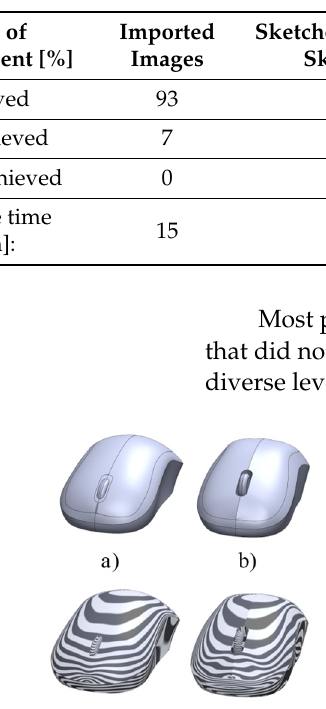
Table 2. Desktop modelling participant study—level of task achievement.